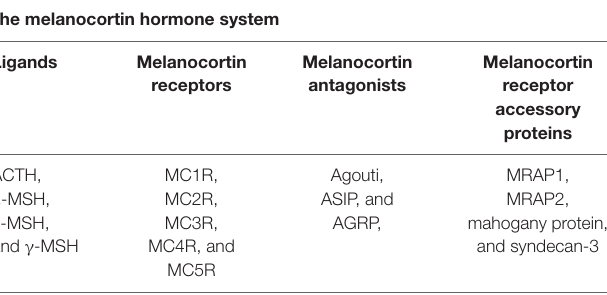
TABLE 1 | Constituent components of the melanocortin hormone